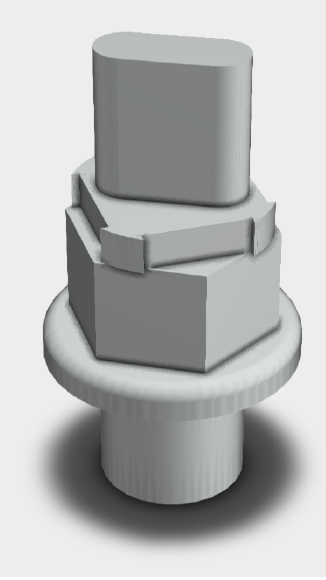
Figure 5. HPCR pressure